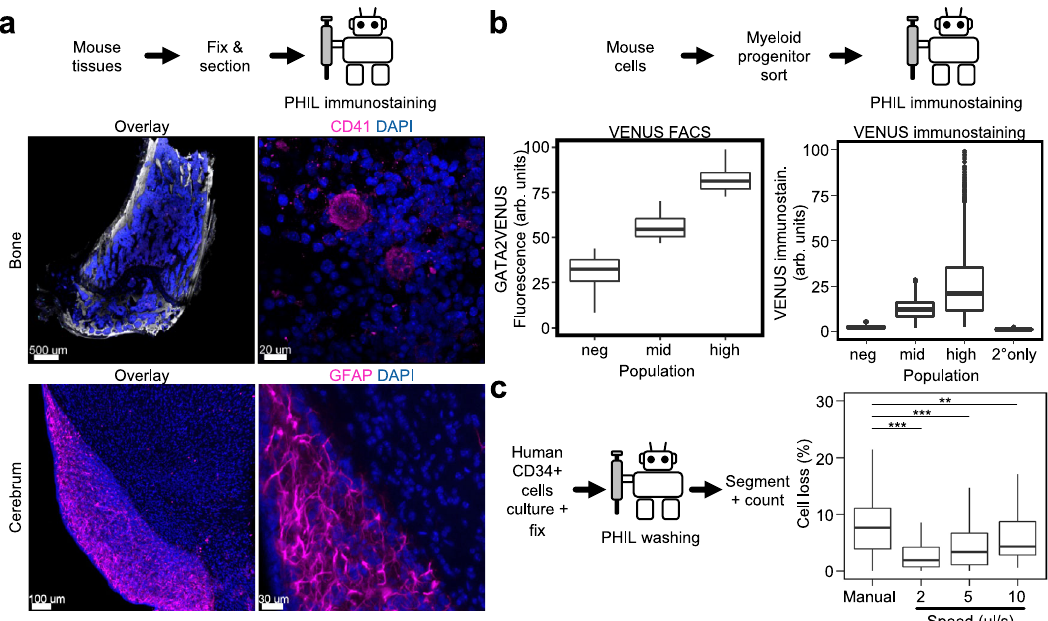
Fig. 5 PHIL successfully automates single cell and whole tissue immunostaining procedures. a Fixed and cleared murine bone and cerebrum samples were sectioned before automated PHIL immunostaining and imaging. PHIL immunostaining preserved normal tissue morphology with intact macroscopic (left) and subcellular (right) features. Compare Supplementary Fig. 5 for comparison to a manually pipetted sample ( n = 2 experiments). b Murine myeloid progenitors were sorted into GATA2VENUS-negative, -middle, and -high populations, plated and fi xed with 4% formalin, and PHIL immunostained against VENUS with and without primary antibodies and imaged. VENUS quanti fi cation of PHIL immunostained samples showed Venus negative, mid and high in both microscopy and FACS analyses ( n = 2 experiments) and showed no antibody cross-contamination. The relative brightness of the different populations followed the same trend when observed via FACS or microscopy and was consistent with previously conducted manual immunostainings on the same populations 31 . Box plot features, from top to bottom, represent maximum, 3rd quartile, median, 1st quartile, and minimum values. c Automated washing improves cell loss for fl ow sensitive samples over manual pipetting. Human umbilical cord CD34 + hematopoietic stem and progenitor cells, cultured for 1 day in a μ -Slide VI 0.4 prior to fi xation, were washed once with 100 μ L manually or with 2, 5, and 10 µ L/s fl ow. Culture channels were imaged and counted before and after washing. Mean cell loss for manual versus 2, 5, and 10 µ L/s were 12.6 versus 3.6%, 4.3%, and 6.1% respectively ( p -values from top to bottom: 0.0094, 0.0009, 0.0004, two-tailed t -tests with Benjamin – Hochberg multiple test correction, n = 2 experiments). Box plot features, from top to bottom, represent maximum, 3rd quartile, median, 1st quartile, and minimum